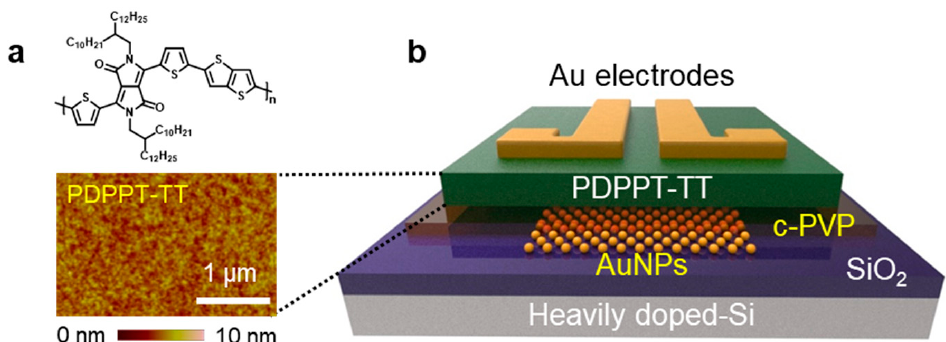
Figure 1. ( a ) Molecular structure of as-synthesized PDPPT-TT and atomic force microscopic image of as-coated PDPPT-TT layer; ( b ) schematic of the PDPPT-TT-based thin-film transistor containing c-PVP/AuNPs layers for non-volatile memory applications.